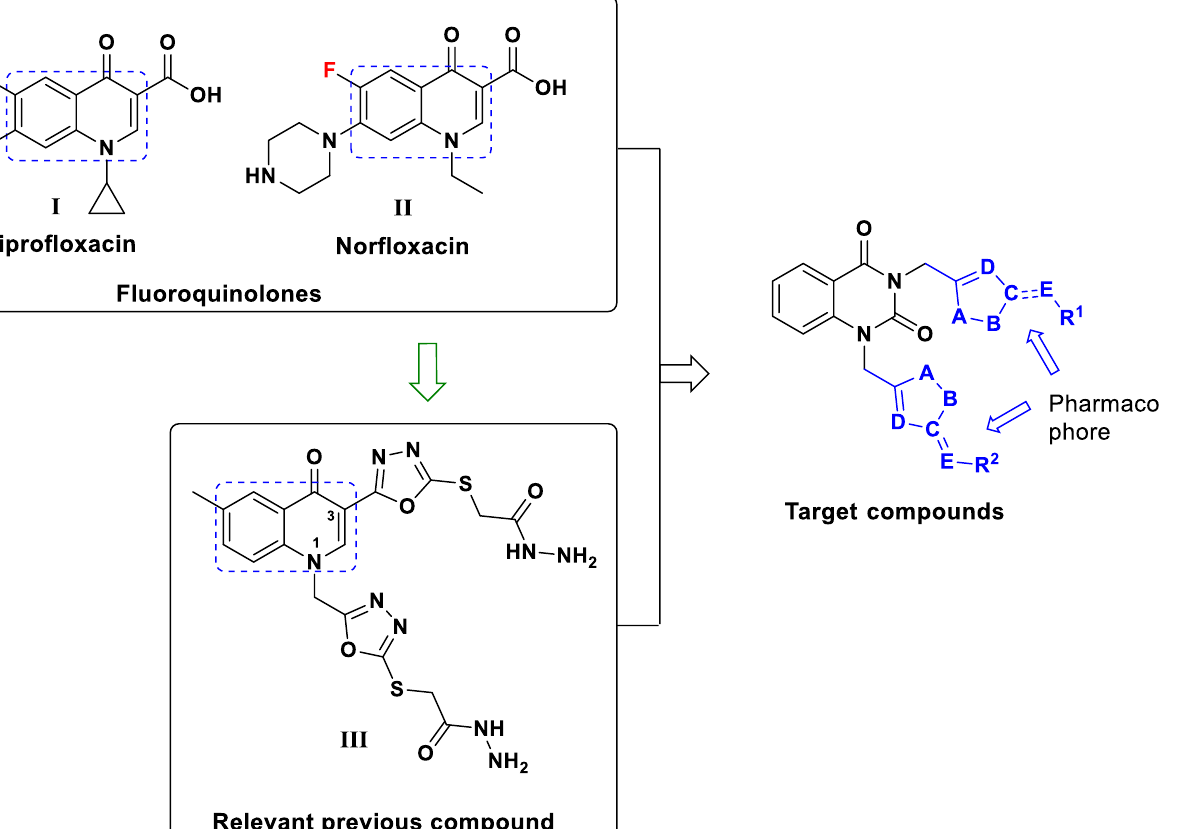
Figure 1. The design of the target compounds based on the relevant previous compound [48]